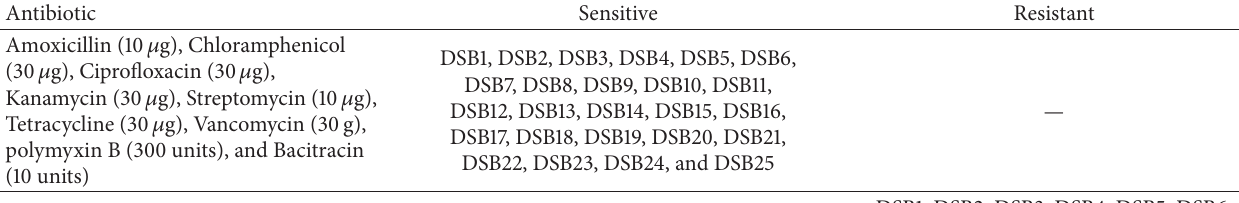
Table 5: Antibiotic sensitivity tests of the isolated Bacillus spp. against some standard antibiotics.